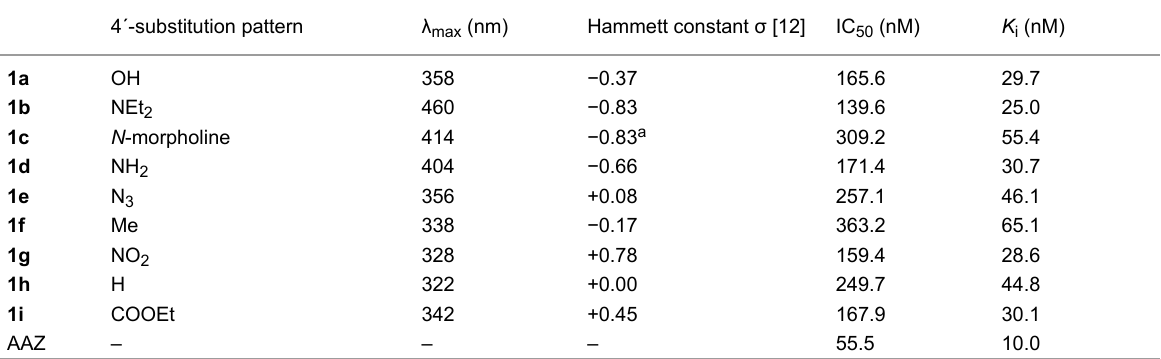
Table 1: Maximal absorbance wavelength ( λ max ), Hammett constants ( σ ) and inhibitory characteristics (IC 50 and K i ) of 1a – i